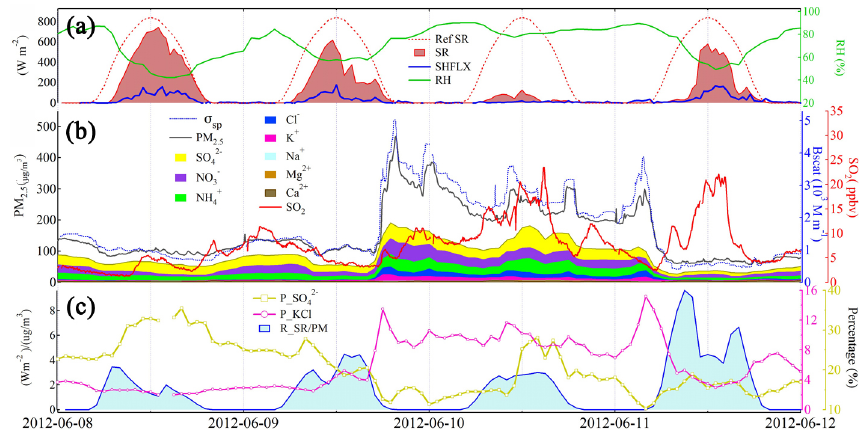
Fig. 3. (a) Solar radiation, sensible heat flux and relative humidity recorded at a urban flux site of SORPES. (b) PM 2 . 5 mass, water-soluble ions, aerosol scattering coefficient (at 650nm) and SO 2 measured at the SORPES Xianlin site. (c) Proportions of sulfate and KCl in the total PM 2 . 5 mass and the ratio of “blocked” solar radiation over the PM 2 . 5 mass concentrations (R_SR/PM = (Ref_SR-SR)/PM 2 . 5 ) at the Xianlin Site. Note: a reference of clear-sky solar radiation (Ref_SR) was determined from the measured solar radiation in the afternoon of 13 June, when Nanjing was cloud-free and with relatively low PM 2 . 5 ( ∼ 50µgm − 3 ) .